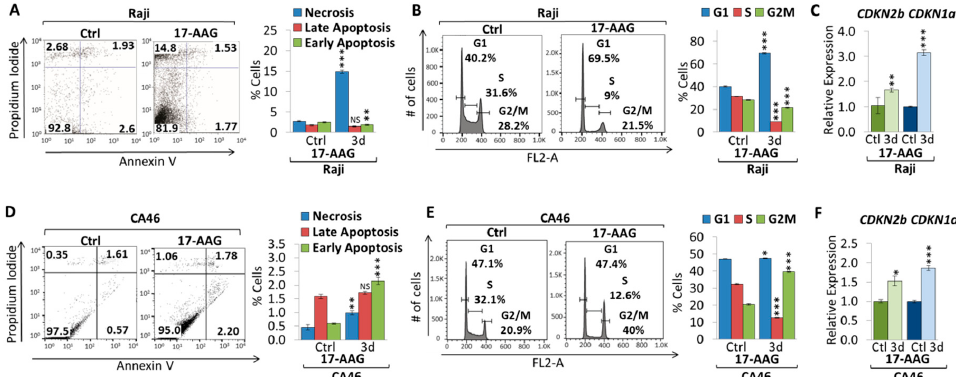
Figure 2. 17-AAG treatment causes apoptosis and cell cycle arrest in Burkitt lymphoma. Flow cytometric analysis of apoptosis using AnnexinV/PI staining. Flow cytometry profile of AnnexinV staining (X axis) and PI (Y axis) is shown for ( A ) Raji and ( D ) CA46 cell lines upon three days treatment with 4 µ M 17-AAG. The lower right quadrant indicates the percentage of early apoptotic cells in each condition; the upper right quadrant indicates the percentage of late apoptotic cells; the upper left quadrant indicates percentage of necrotic cells; and the left lower quadrant indicates percentage of live/non-apoptotic cells. Apoptotic cells (Annexin V-positive cells) are displayed as the percentage of gated cells. Flow cytometric cell cycle analysis using propidium iodide (PI) staining in ( B ) Raji and ( E ) CA46 cell lines upon three days treatment with 4 µ M 17-AAG. Cell cycle distribution (G1, S and G2/M) are displayed in percent. RT-qPCR of CDKN2b and CDKN1a upon three-day treatment of 4 µ M 17-AAG or MeOH in ( C ) Raji and ( F ) CA46 cell lines. RT-qPCR was normalized to RPL13a . Error bars represent mean ± SEM; n = 3; two-tailed Student’s t -test: NS = not significant; * p < 0.05; ** p < 0.01; *** p <